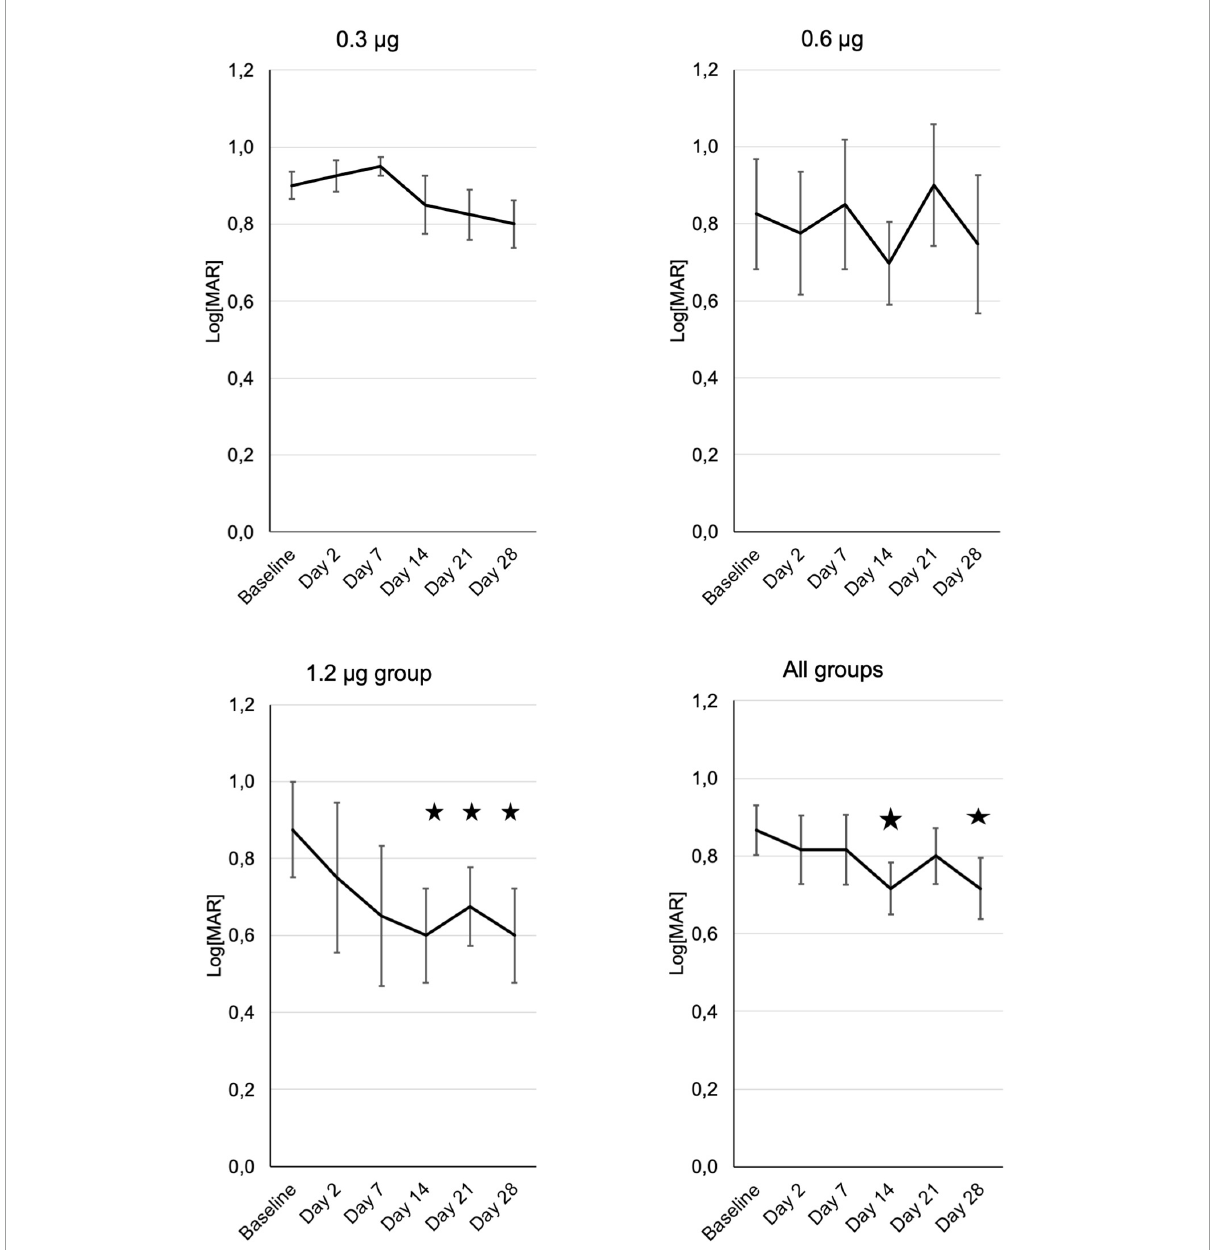
FIGURE2 Development of visual acuity in the three treatment groups ( n = 4) from baseline until the end of the study at day 28, assessed at the respective visits. “All patients” shows the means of visual acuity ± SE from all patients of the different treatment groups. Note that decreasing Log[MAR] values represent increasing visual acuity. Asterisks represent significant ( p ≤ 0.05) differences to